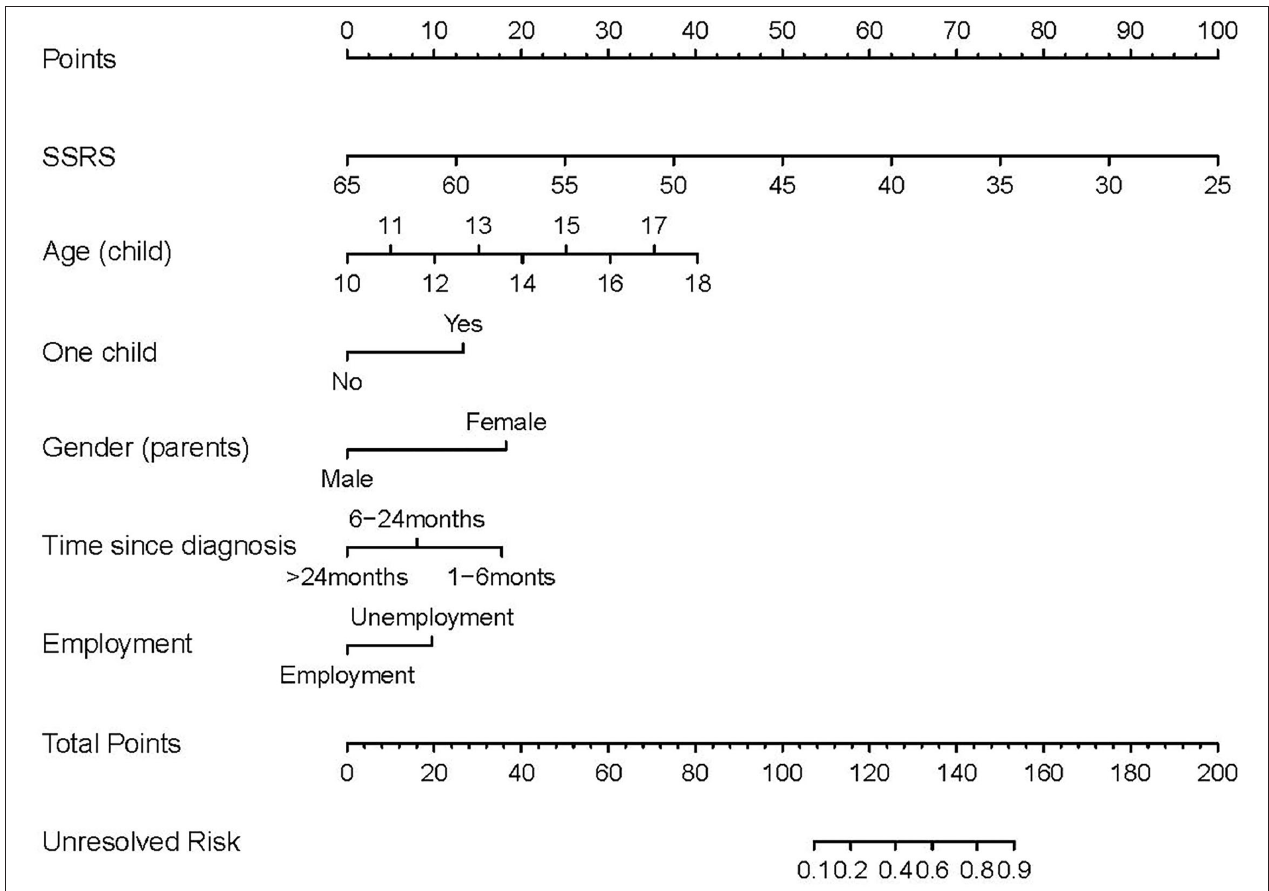
FIGURE 1 | Nomogram for predicting the unresolved risk of parents of children with psychiatric diagnoses. Each risk factor of the parents has a value on its variable axis, and vertical lines are drawn upward to the point axis to obtain the corresponding scores for the value of each risk factor. A total score can be easily calculated by adding each single score. The total score is plotted on the bottom total point axis, and a vertical line is drawn downward to the unresolved risk axis to estimate the unresolved